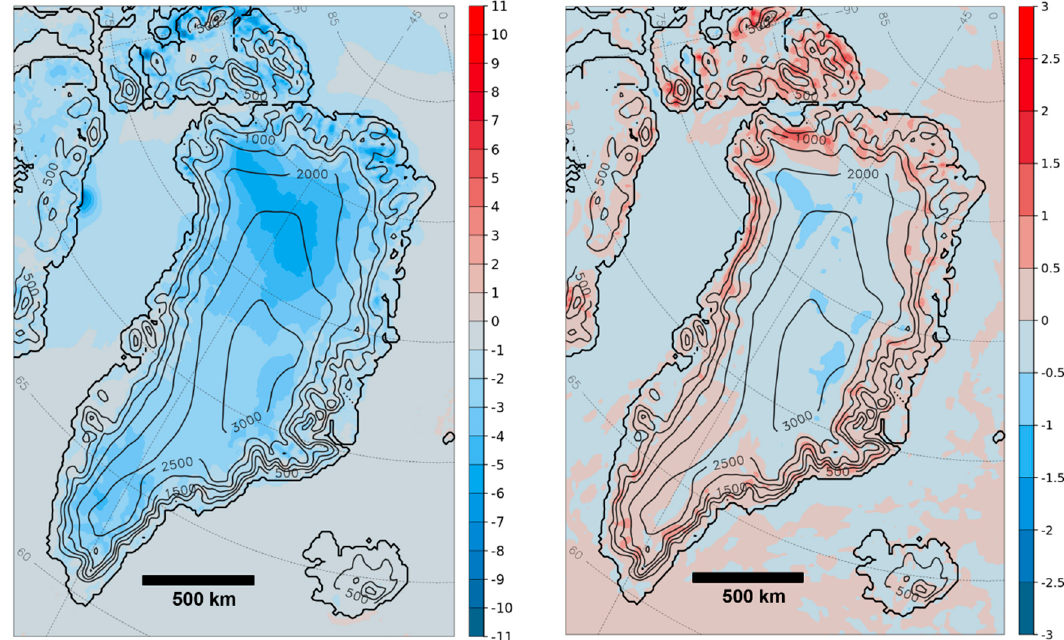
Figure 5. Difference between runs using the different turbulence parameterizations (mod–def) as the monthly average for April 1997 for the 2 m temperature (in K, left ) and the 10 m wind speed (in m/s, right ).